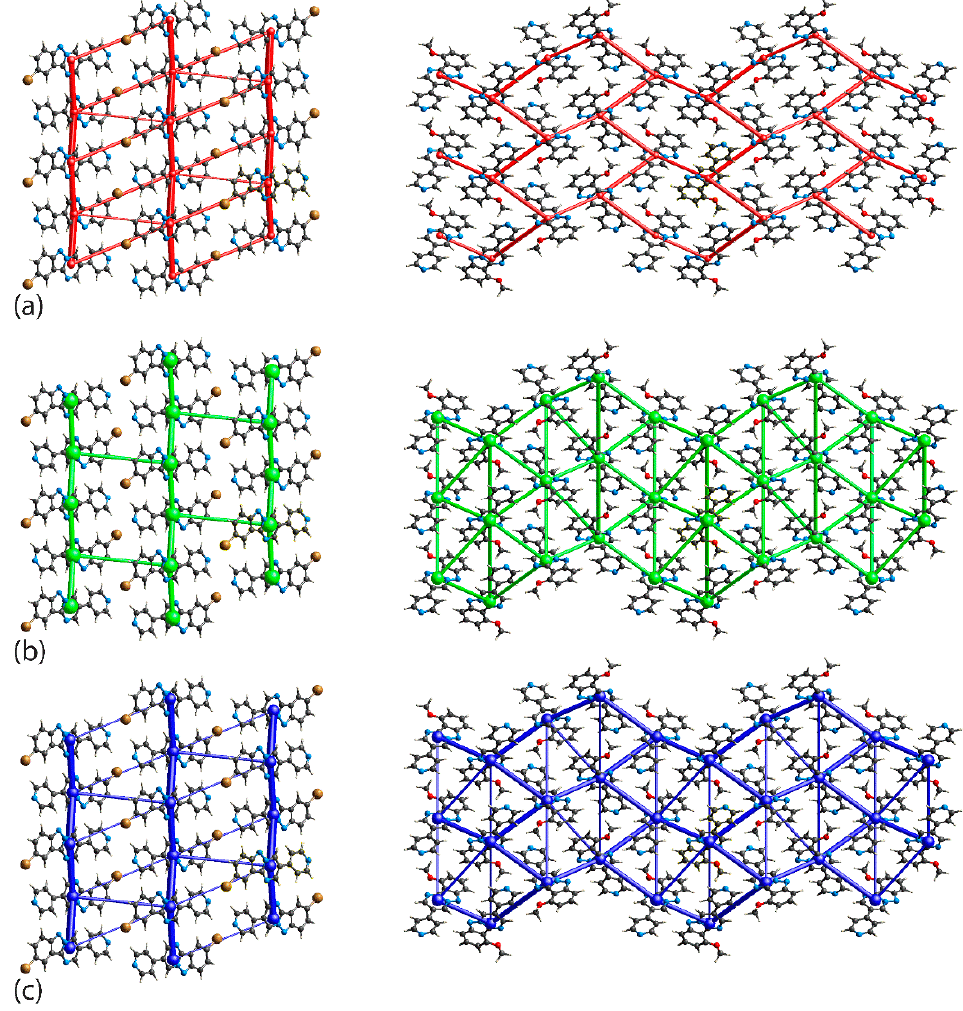
Figure 10. Perspective views of the ( a ) electrostatic energy; and ( b ) dispersion force and ( c ) overall energy frameworks for 1b (left) and 1c (right). The cylindrical radius is proportional to the relative strength of the corresponding energies. and they were adjusted to the same scale factor of 100 with a cut-off value of 8 kJ/mol within a 2 × 2 × 3 unit cells.